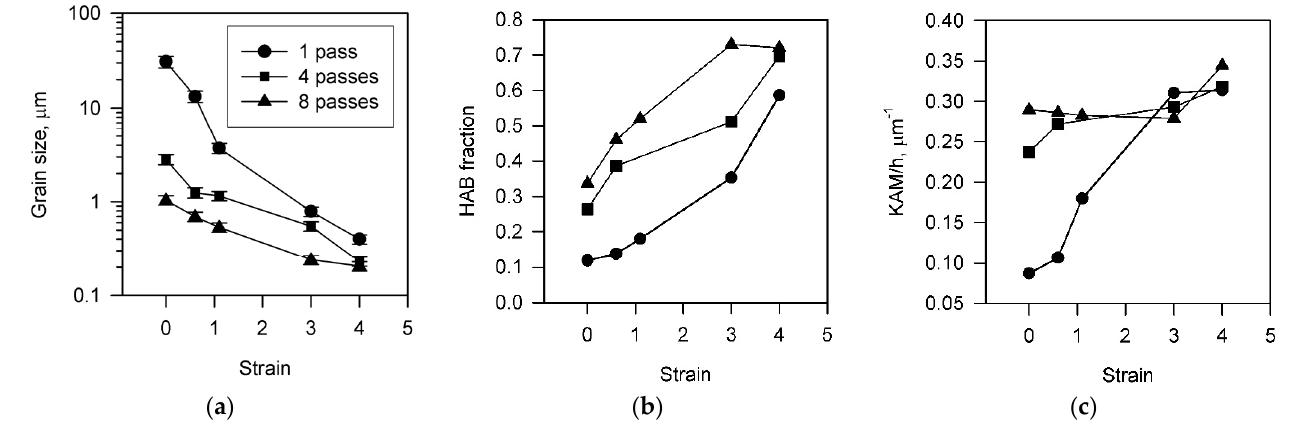
Figure 3. The change in the grain size ( a ), the HAB fraction ( b ), and the internal distortions as a KAM/h ratio ( c ) in a Cu-Cr-Zr alloy subjected to 1 to 8 passes of ECAE-Conform followed by cold rolling to various total